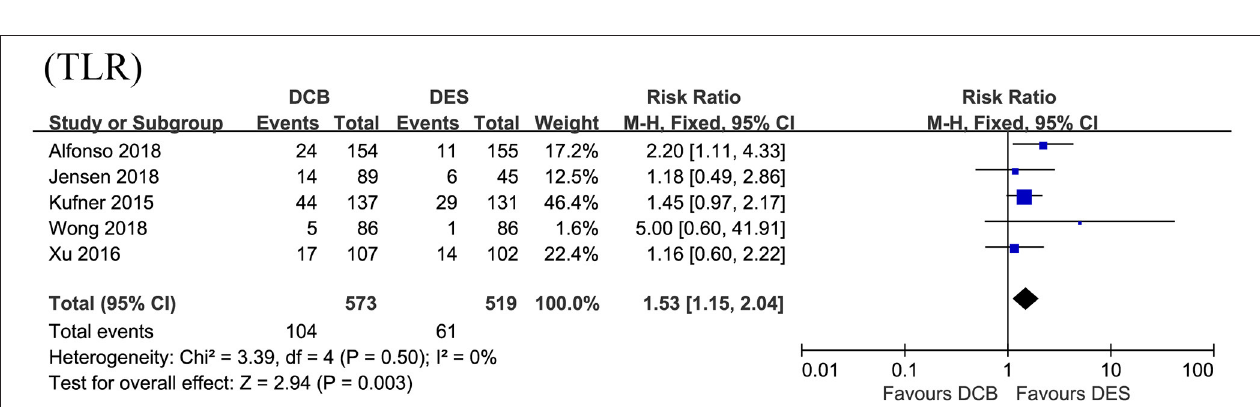
FIGURE 2 | Forest plot of comparing angiographic outcomes in MLD (A) , DS% (B) , LLL (C) , and binary restenosis (D) between repeat DES implantation and DCB angioplasty. MLD, minimum lumen diameter; DS%, percent diameter stenosis; LLL, late lumen loss; DES, drug-eluting stents; DCB, drug-coated balloon; PES, paclitaxel-eluting stents; EES, everolimus-eluting stents.